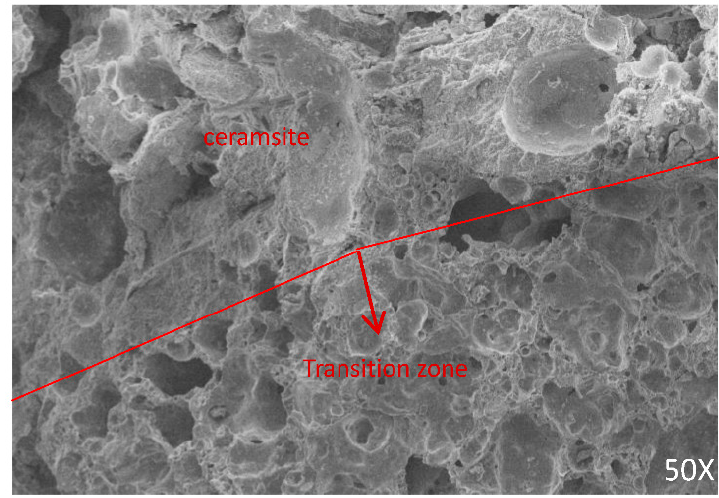
Figure 11. Micrograph of the porous surface of the cement matrix and ceramsite.